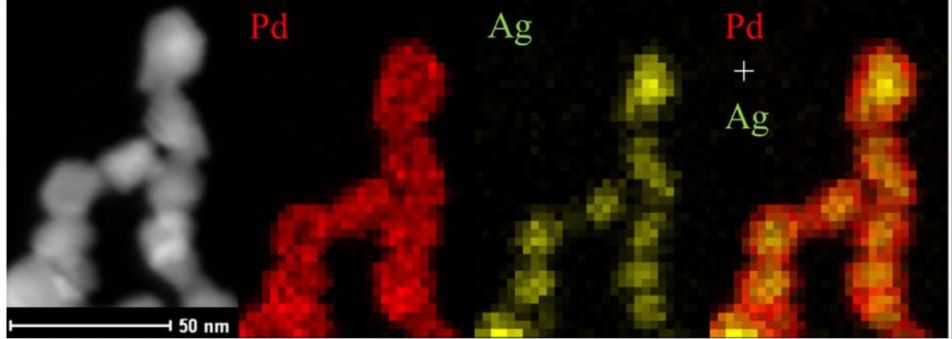
Figure 2. Compositional mapping images of PdAg@Pd core–shell structures, reprinted with permis- sion of Elsevier